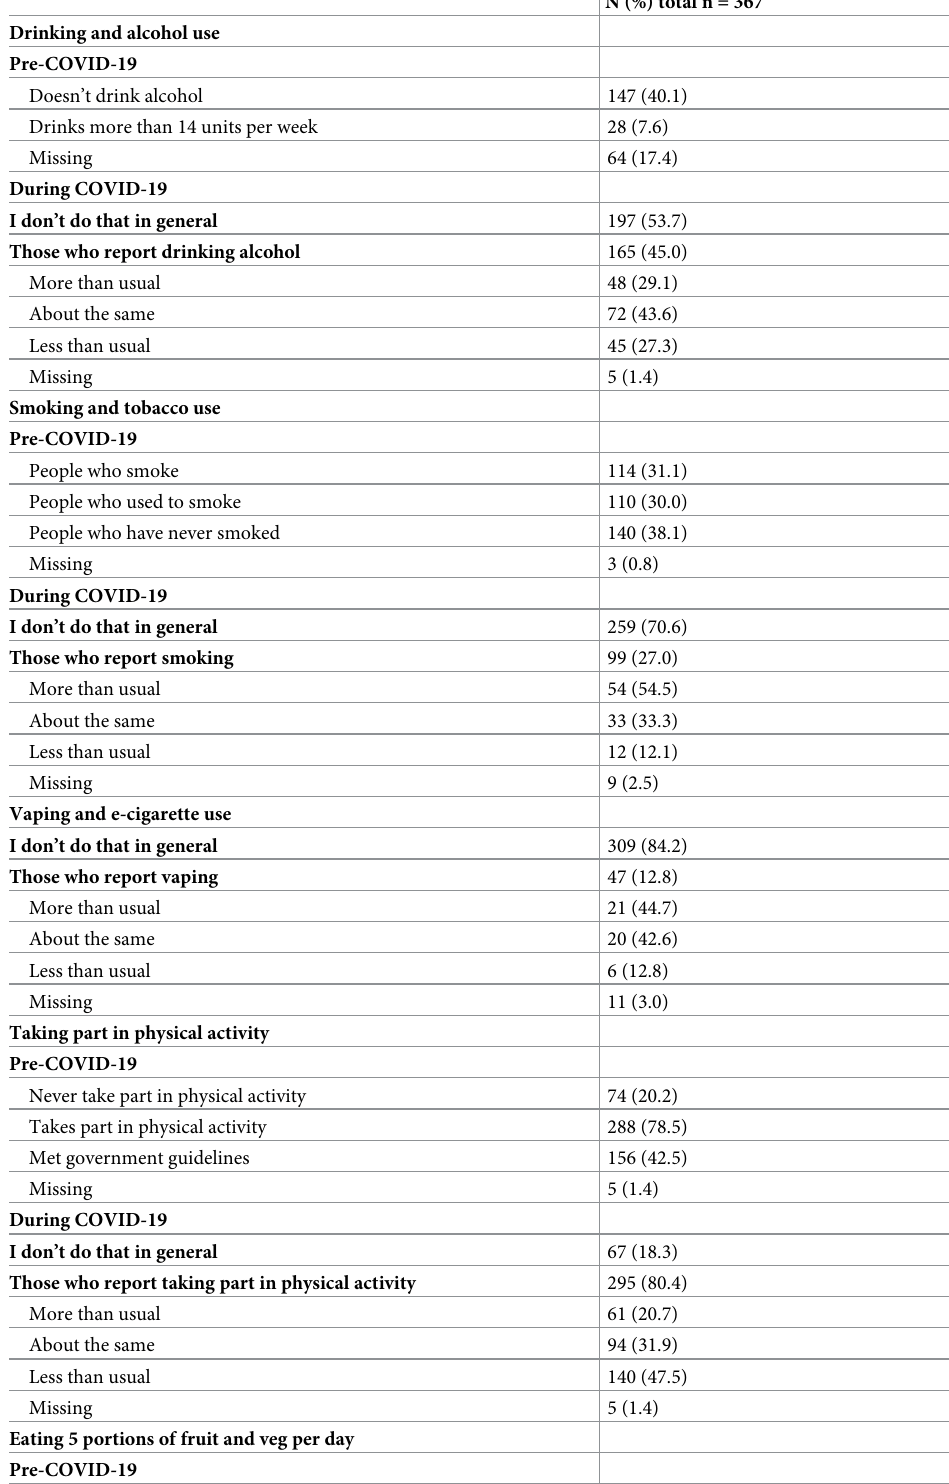
Table 2. Self-reported health and health risk behaviours for the OWLS COVID-19 study